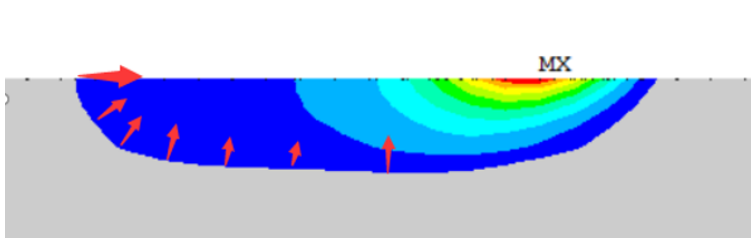
Figure 6. Solidification velocity direction of the liquid – solid interface.